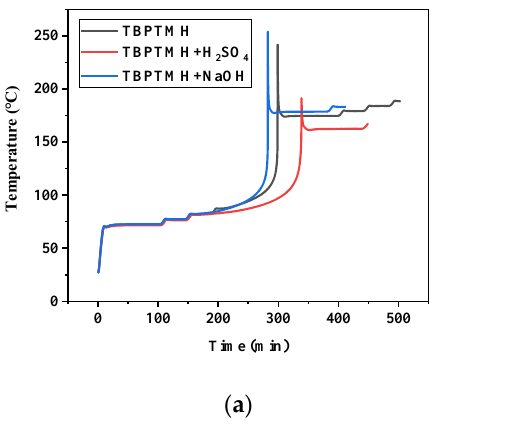
Table 4. Thermal decomposition characteristic parameters of TBPTMH.